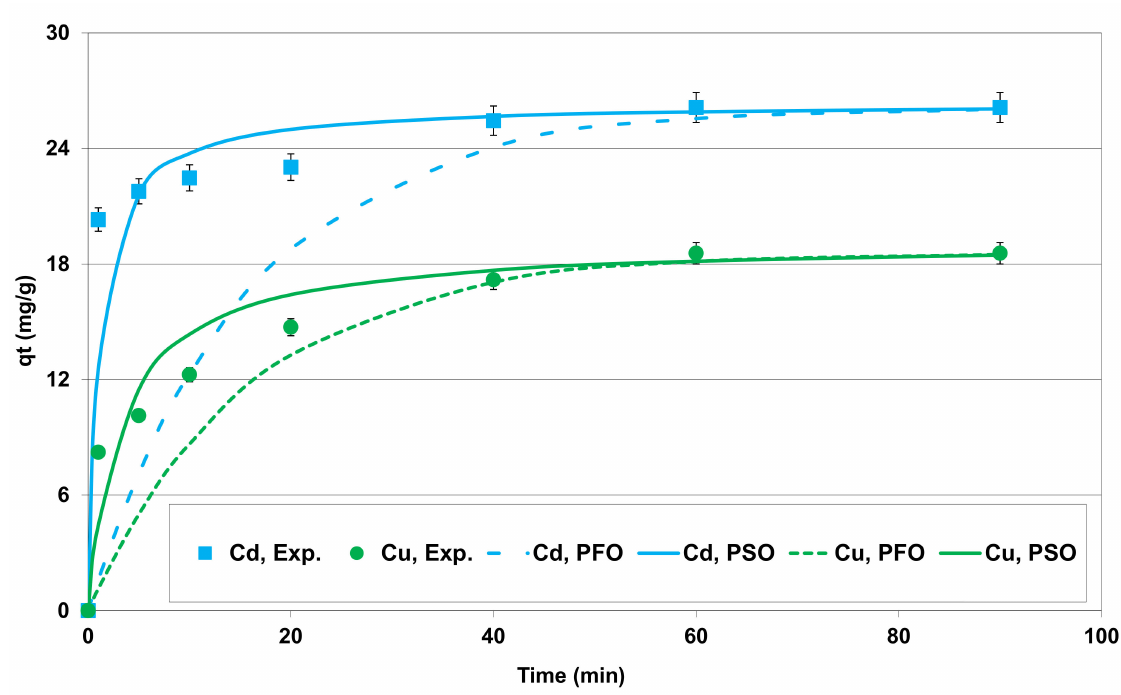
Figure 2. Kinetics of Cd and Cu removal by lignite and its fitting with PFO and PSO models (C 0 = 100 mg L − 1 , D = 2 g L − 1 ; t = 60 min; pH = 5; T = 20 ± 2 ◦ C; Exp.: Experimental value).